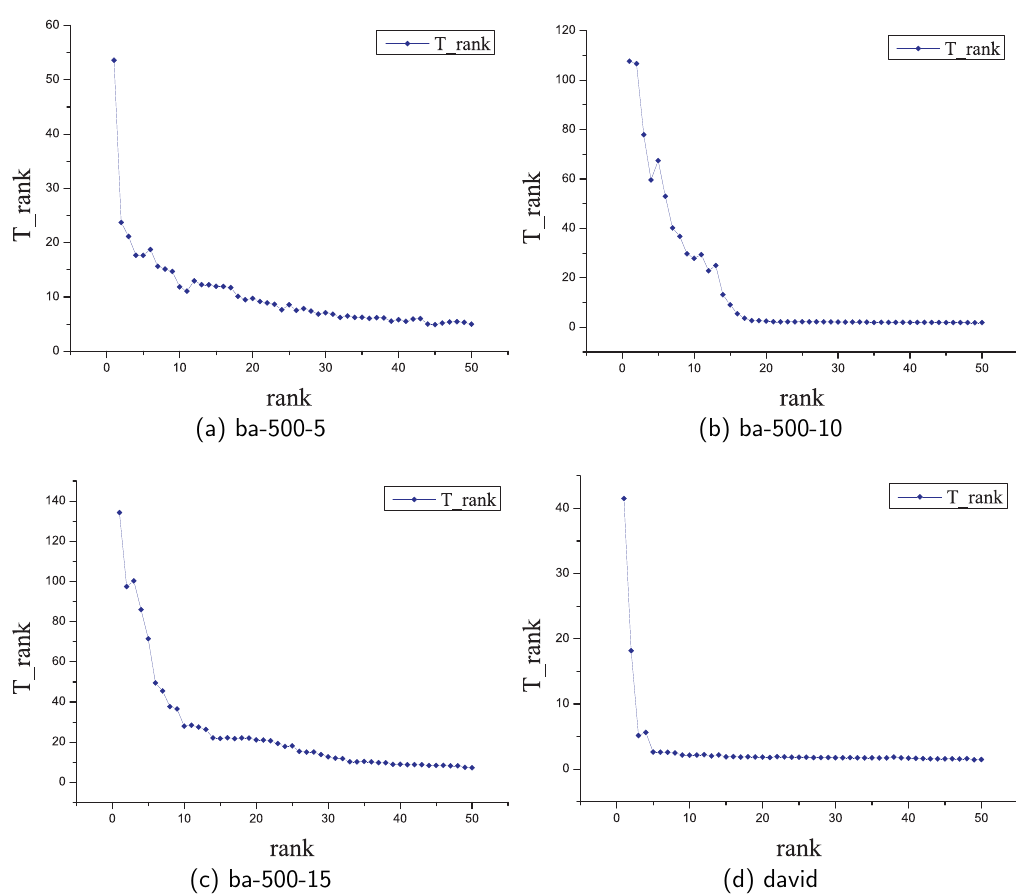
Figure 7. Evaluate the efficiency of the FastTopRank algorithm.